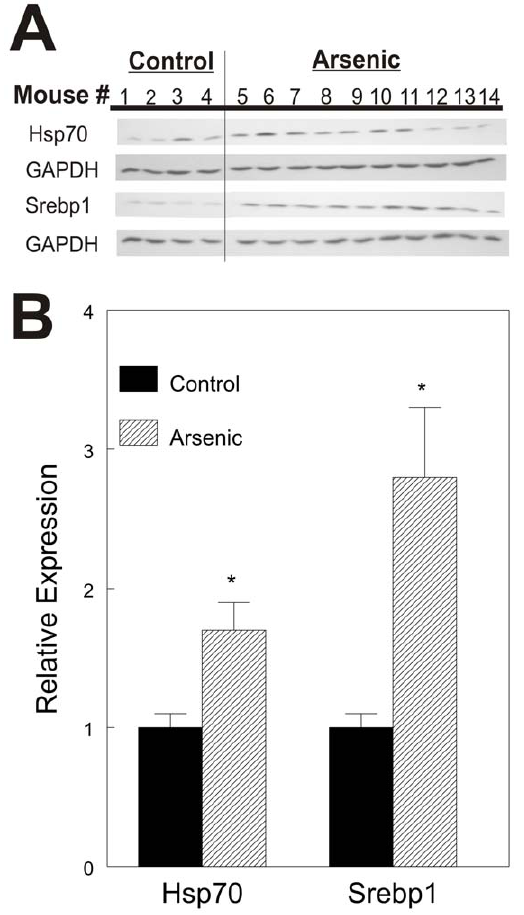
Figure 6. HSP70 and SREBP1 expression in livers of 10 week old mice. A. Western blot analysis of HSP70 and SREBP1. The SREBP1 fragment shown is the 68 kDa cleavage fragment. B. Densitometric quantitation of western blots. Signals for each protein were normalized to GAPDH and mean of controls ( # ’s 1–4) was set=1. Representative of triplicate blots shown. *=p , 0.05.